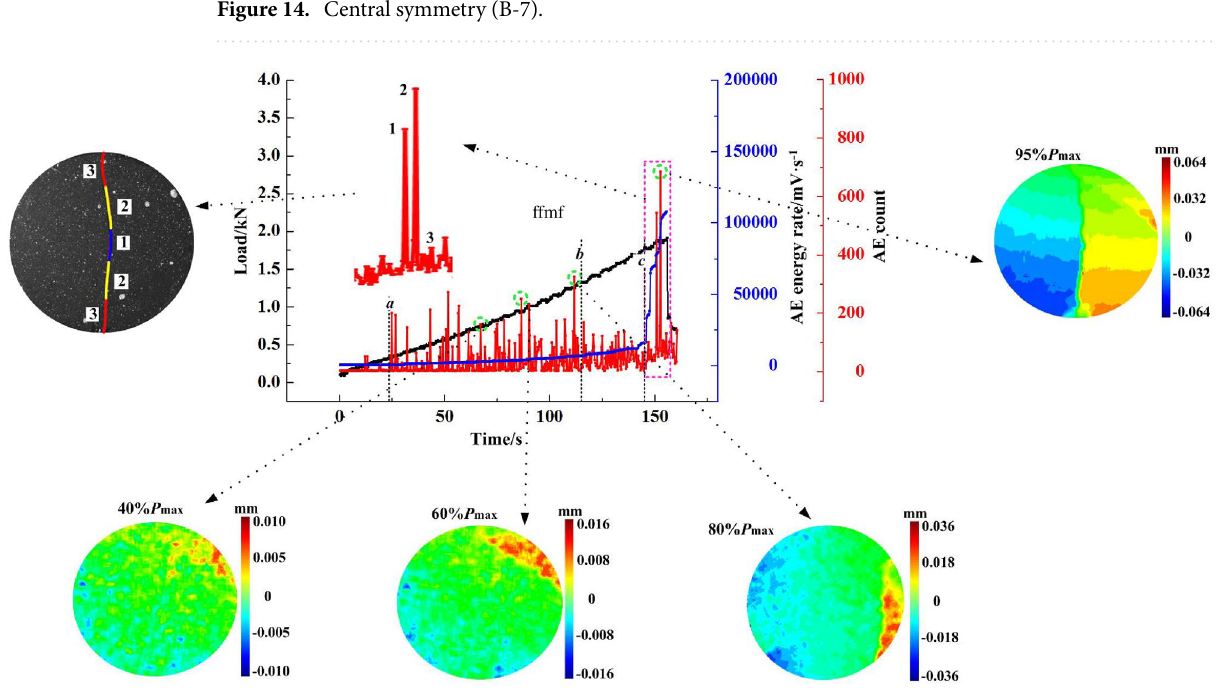
Figure 15. Axis symmetry